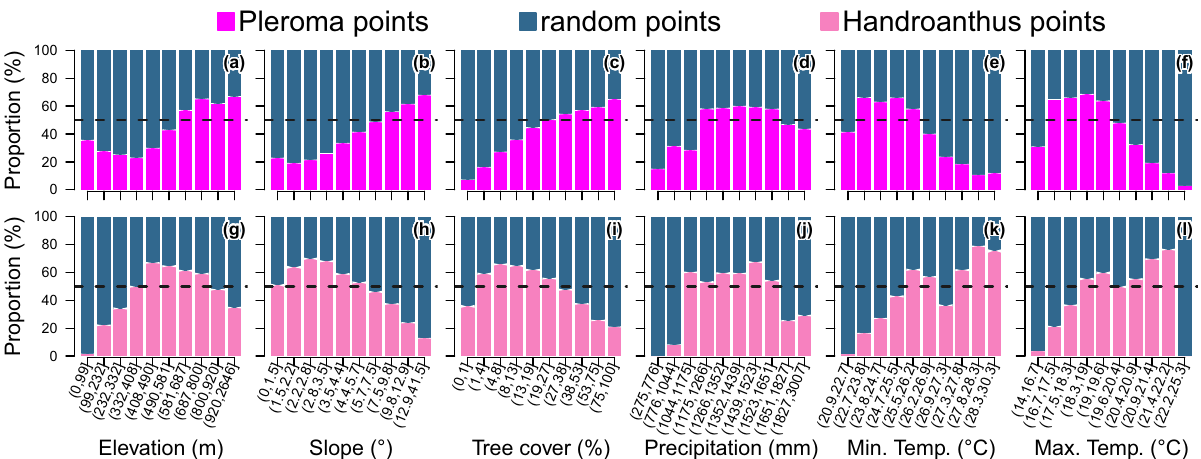
Figure 11. Comparison of the proportion of Pleroma trees ( a – f ) and Handroanthus trees ( g – l ) in relation to the proportion obtained by random sampling over the same area, for the quantile classes of elevation, slope, tree cover, precipitation, minimum and maximum temperatures. Barplots of the first and second row are computed respectively with 112039 observations of Pleroma (all clusters excluding 6 and 11) and 26177 observations of Handroanthus (clusters 6 and 11, located on the western part of Atlantic Forest domain). All these observations are compared to the same number of random locations over the Atlantic Forest. The random locations are bootstrapped 100 times to create the 95% confidence interval. For example, in the first row, for a given elevation class, if the confidence interval intersects with 50% (black dashed line), there is no significant difference between the distribution of Pleroma and a random distribution for this class at 5% significance level.